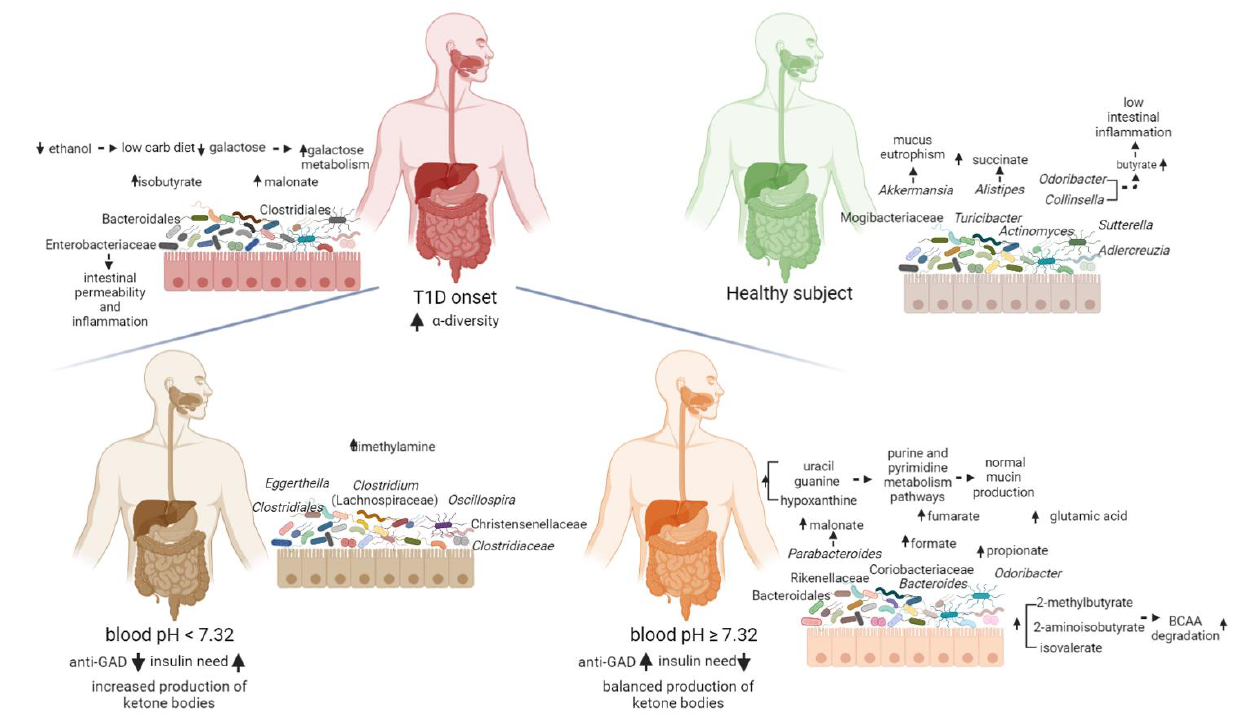
Figure 5. Functional descriptive model of T1D gut microbiota at onset predicting the host–microbiota interaction. Blood pH and anti-GAD antibodies resulted to be good clinical biomarkers to characterize the gut microbiota specific and functional features at the onset of T1D. T1D patients were characterized by high levels of isobutyrate, malonate, Clostridium (Lachnospiraceae), Enterobacteriaceae, Bacteroidales and Clostridiales unk. families, while CTRL showed higher levels of butyrate, galactose, ethanol, succinate, Odoribacter , Alistipes , Akkermansia , Sutterella , Actinomyces , Adlercreutzia , Collinsella , Turicibacter and Mogibacteriaceae. T1D pH ≥ 7.32 patients showed high values of malonate, uracil, formate, 2-methylbutyrate, fumarate, hypoxanthine, guanine, isovalerate, propionate, 2-aminoisobutyrate and glutamic acid (Glu), Odoribacter , Bacteroides , Parabacteroides , Rikenellaceae, Coriobacteriaceae and Bacteroidales. In T1D pH < 7.32 patients were higher levels of dimethylamine (DMA), Eggerthella , Clostridium (Lachnospiraceae), Oscillospira , Christensenellaceae, Clostridiaceae and Clostridiales. Created with BioRender.com.